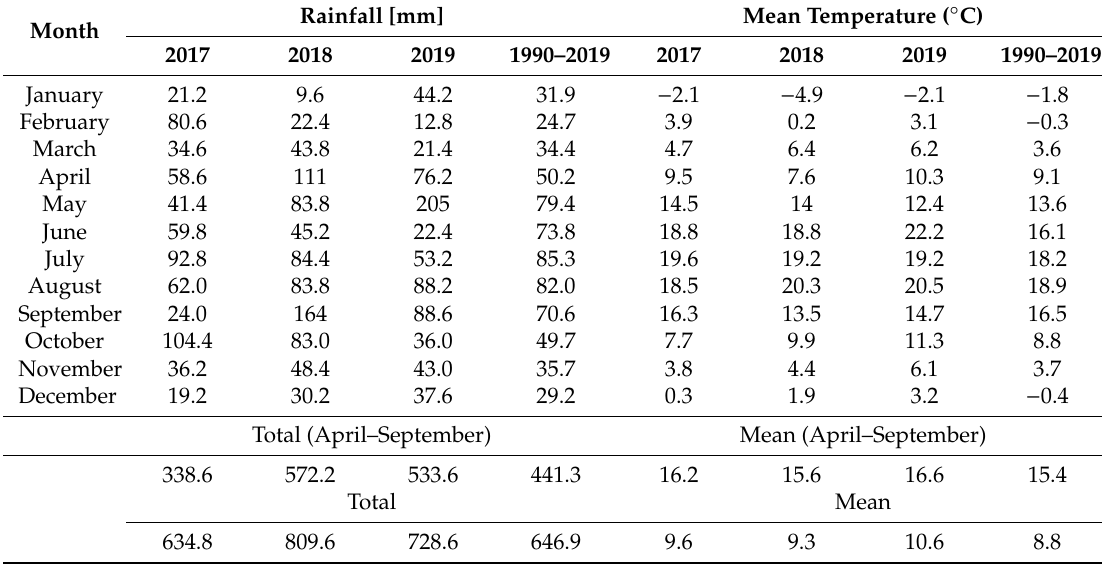
Table 1. Rainfall and mean air temperature between 2017 and 2919, compared to mean multiannual temperature (1990–2019), at the Experimental Station in Prusy, University of Agriculture in Krak ó